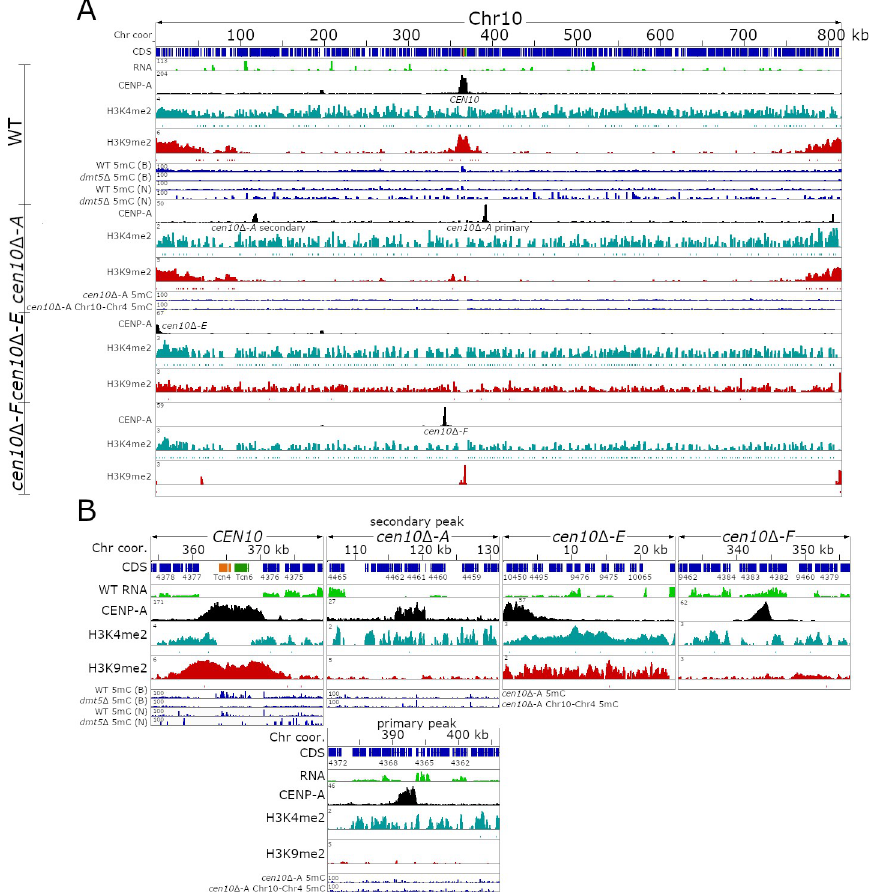
Fig 2. C . deuterogattii neocentromeres are not enriched for H3K9me2. For each panel, the chromosome coordinates are indicated. CDS are shown in blue, TEs are presented as per the specific TE family color, and RNA-seq is shown in green. CENP-A ChIP-seq is shown in black, ChIP-seq for H3K4me2 is shown in turquoise, and ChIP-seq for H3K9me2 is shown in red. DNA methylation for the wild-type is shown in blue and the source of the 5mC data is indicated by B (Bisulfite sequencing) or N (Nanopore sequencing). (A) The top panel shows the distribution of epigenetics marks of the full-length wild-type Chr10. The lower panels show the epigenetic marks of the full-length Chr10 of cen10 Δ - A , cen10 Δ - E , and cen10 Δ - F strains. As shown cen10 Δ - A has two neocentromeric peaks, while the other isolates only have one centromere on chromosome 10. DNA methylation enrichment for cen10 Δ - A is shown